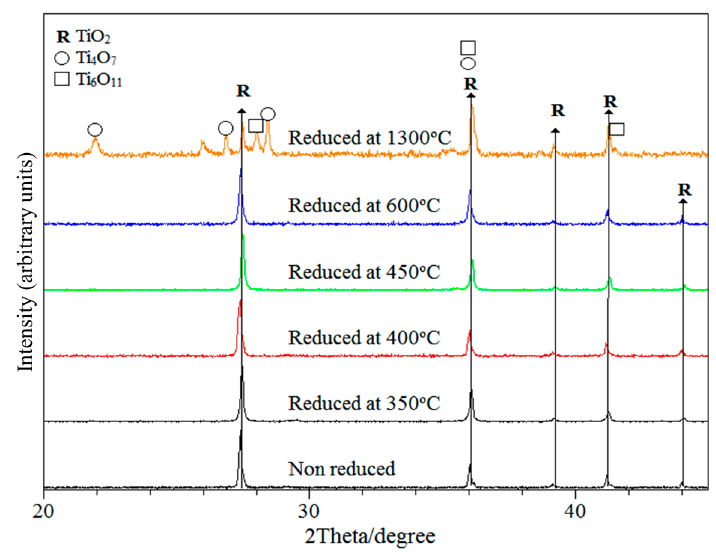
Figure 2. XRD diffraction patterns of non-reduced rutile and TiO n carbo-thermally reduced from 350 °C to 1300 °C.